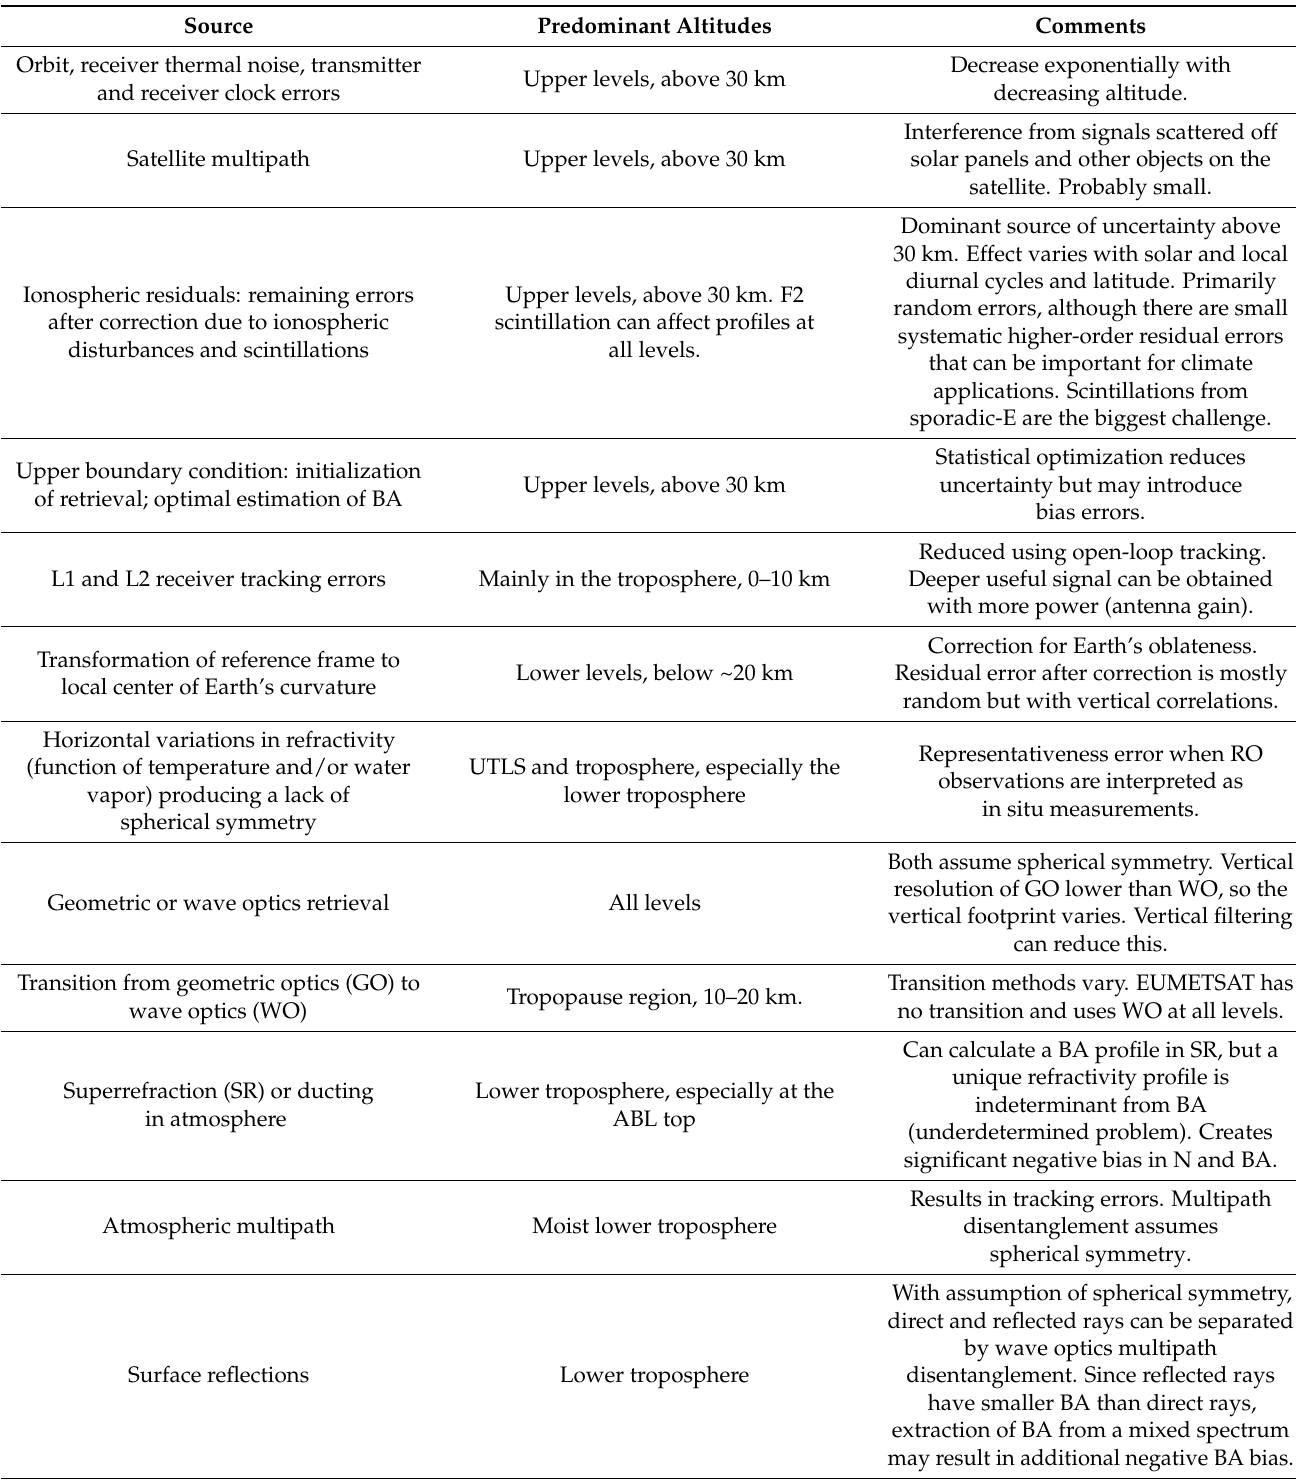
Table 1. Major sources of random errors (uncertainties) and bias errors in radio occultation ob- servations and additional sources introduced by error estimates made by comparison with other data